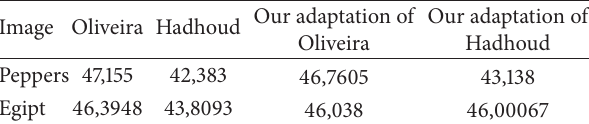
Table 1: PSNR values comparison for the proposed